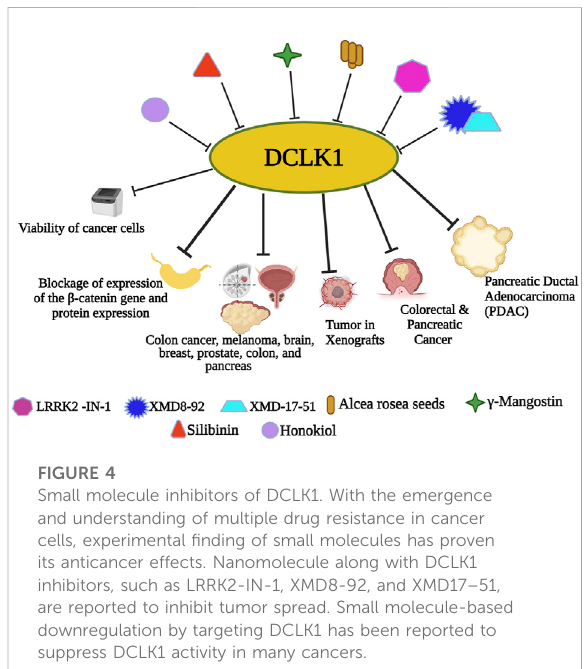
FIGURE 4 Small molecule inhibitors of DCLK1. With the emergence and understanding of multiple drug resistance in cancer cells, experimental fi nding of small molecules has proven its anticancer effects. Nanomolecule along with DCLK1 inhibitors, such as LRRK2-IN-1, XMD8-92, and XMD17 – 51, are reported to inhibit tumor spread. Small molecule-based downregulation by targeting DCLK1 has been reported to suppress DCLK1 activity in many